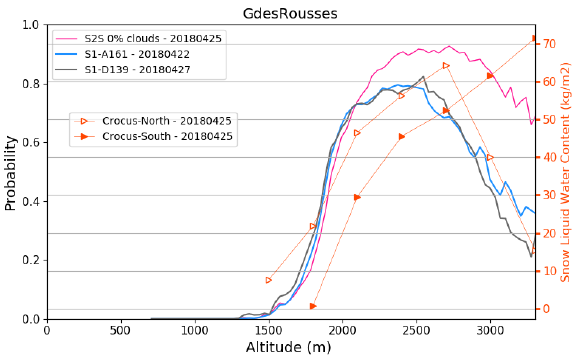
Figure 18. Same as Figure 17 but for dates close to 25 April